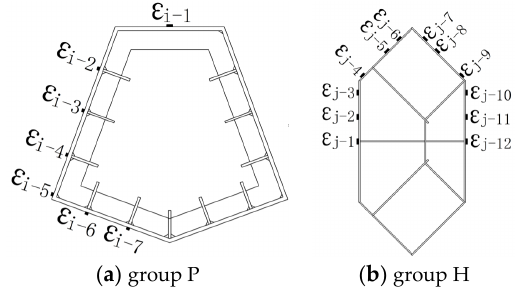
Figure 6. The arrangement of strain gauges.